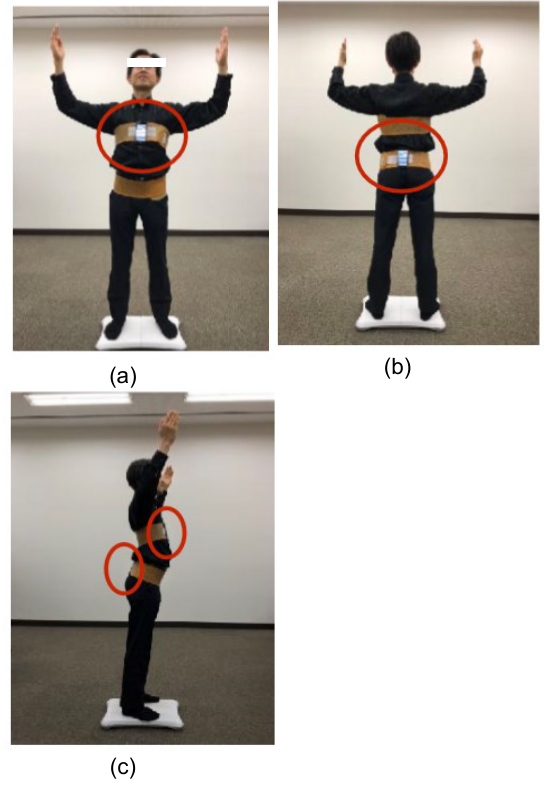
Figure 3. Sensor location in data collection trial: (a) front view; (b) back view; (c) side view. The two iPods were fixed on the chest and on the back of pelvis respectively using